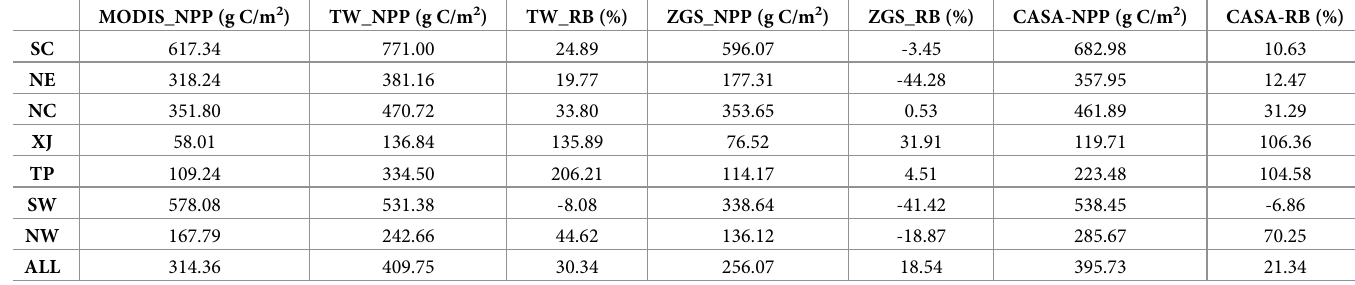
Table 2. RB for the results of three models comparable with reference data (Note: TW represents Thornthwaite Memorial model). MODIS_NPP (g C/m 2 )